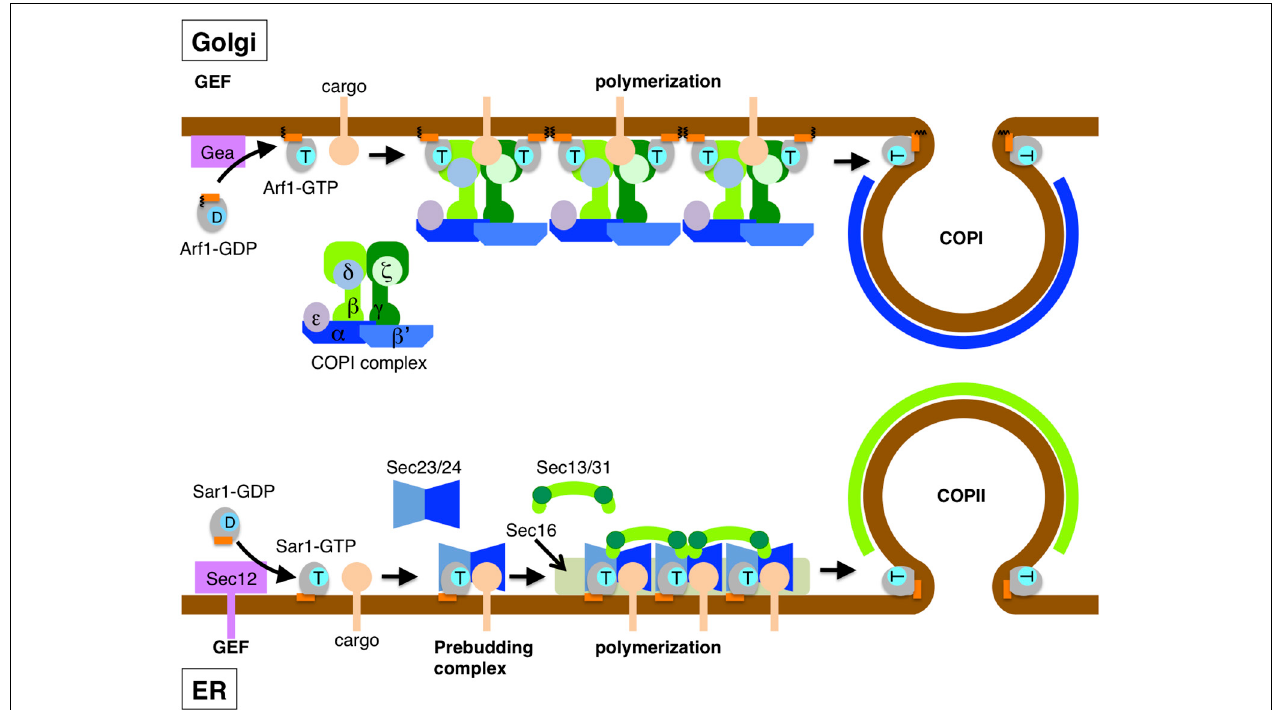
FIGURE 2 | Assembly of COPII and COPI coats drives vesicle formation. Vesicle formation starts upon the recruitment of Sar1 and Arf1 to the ER (lower) and Golgi membranes (upper), respectively. In COPII vesicle formation, the ER integral membrane protein Sec12 exchanges GDP for GTP bound to Sar1 through its GEF activity. Membrane-associated GTP-bound Sar1 recruits the inner coat Sec23/24 complex and then assembles along with cargo protein into the pre-budding complex. Outer coat Sec13/31 complexes are recruited to the pre-budding complexes and self-assembled by crosslinking. The polymerization of Sec13/31 by self-assembly drives membrane curvature